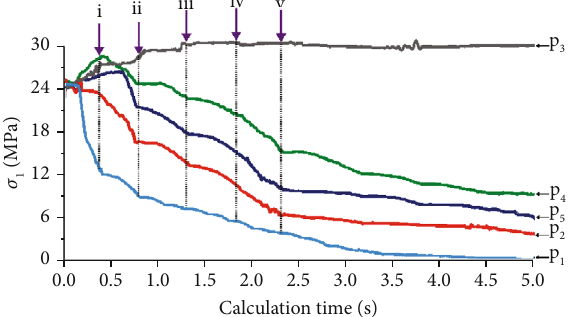
Figure 20: Variation law of maximum principal stress at di ff erent measuring points with the calculation time